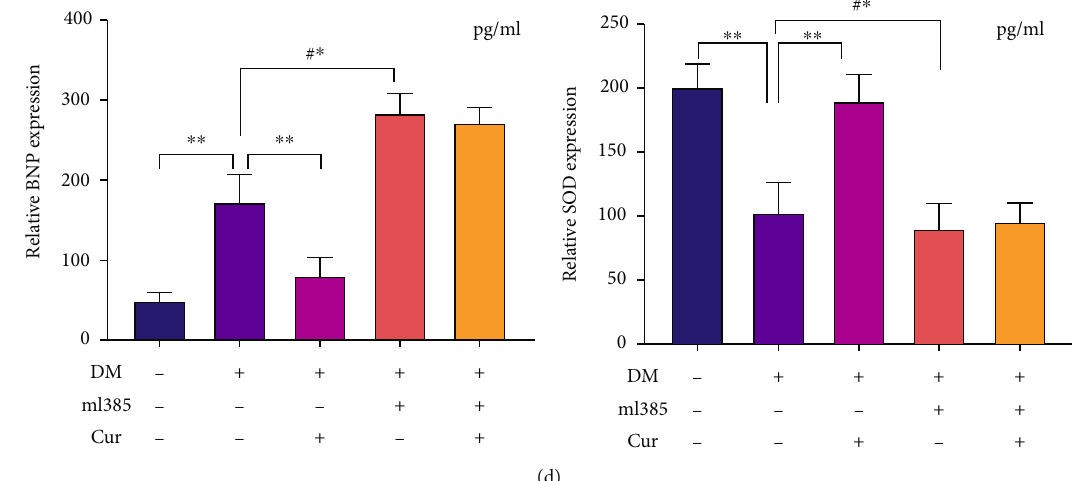
Figure 3: Curcumin inhibits diabetes-induced myocardial pyroptosis. DM: diabetic rat; Cur: curcumin; the dose used in animal experiments was 200 mg/kg/day. ml385: inhibitors of the Nrf2 pathway, the dose used in the experiment was 20mg/kg. (a) The expression of pyroptosis proteins in rat myocardial tissue was detected by western blotting. (b – d) Expression levels of IL-18, IL-1, NF- κ B, TNF- α , BNP, and SOD in the serum of the rats in each group were determined using an enzyme-linked immunosorbent assay vs. the control group and curcumin- treated group. # ∗ P < 0 : 001 : injected with ml385 vs. noninjected with ml385 (in diabetic rats). Values are expressed as the mean ± standard